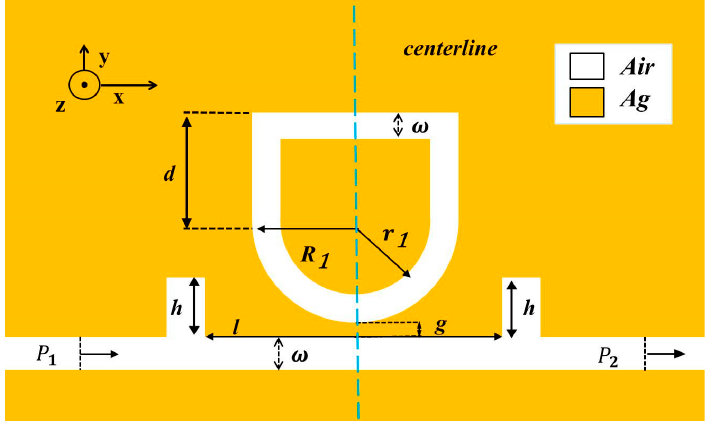
Figure 1. 2D schematic diagram of a USRR resonant cavity coupled with an MIM waveguide with two rectangular baffles.